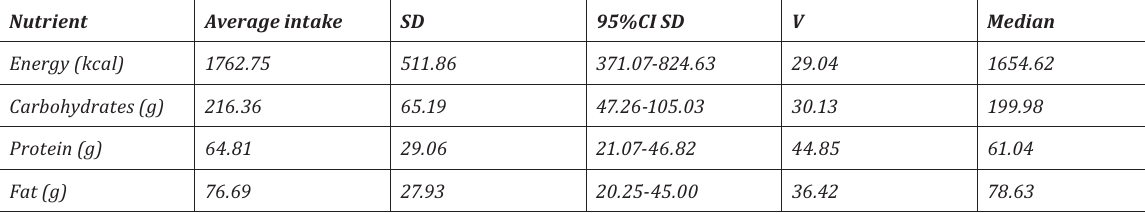
Table 3. Total energy and nutrients intake in the women group